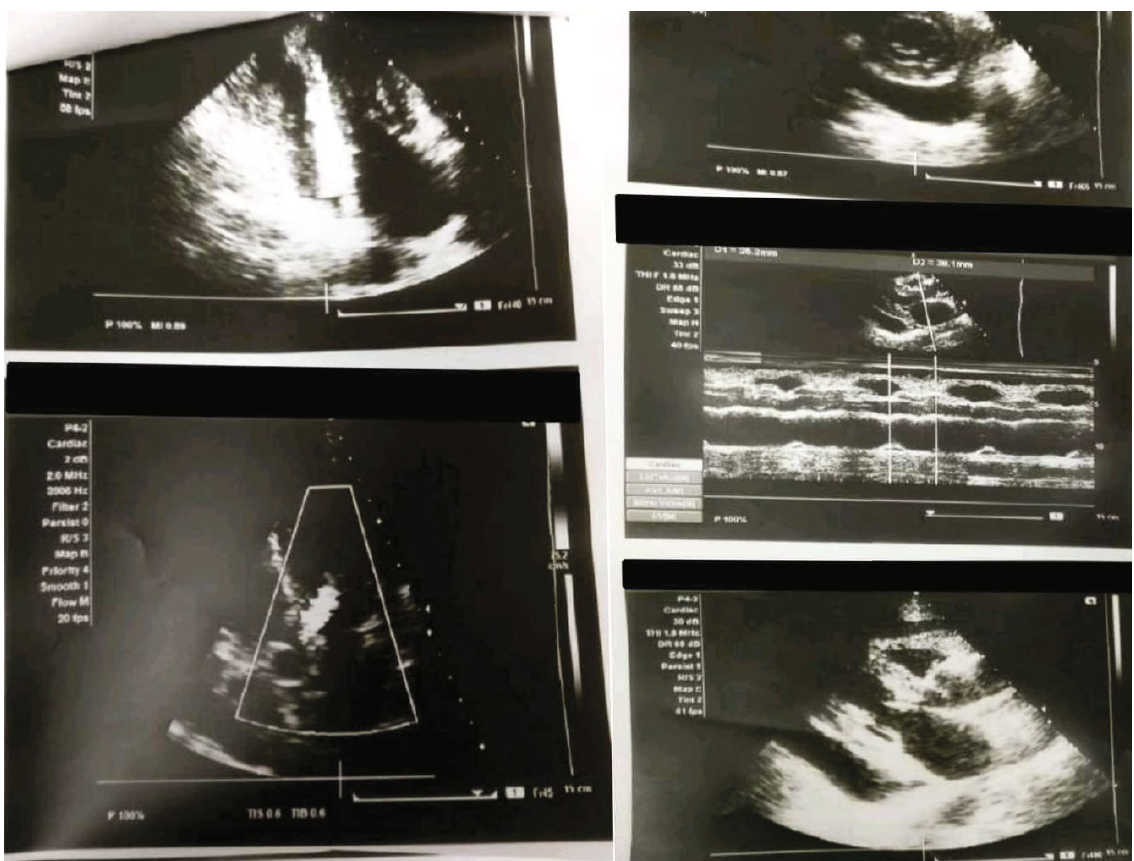
Figure 1: 2D ECHO showing a large pericardial e ff usion with right atrial diastolic collapse suggestive of cardiac